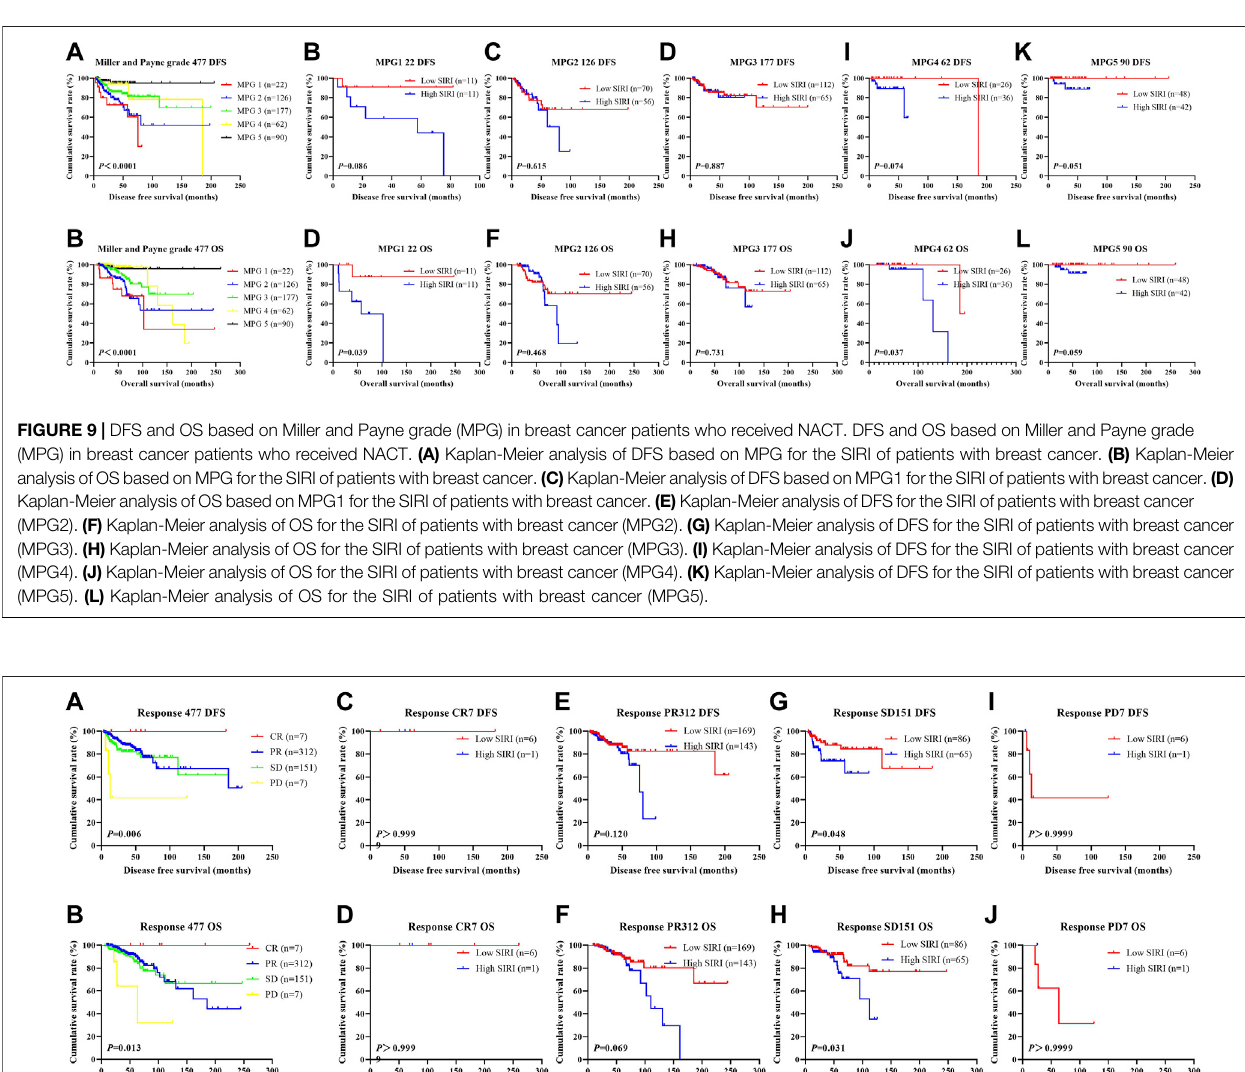
Frontiers in Molecular Biosciences |